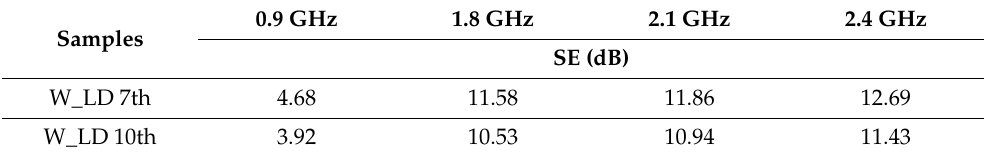
Table 5. Cont. Table 5. Shielding effectiveness (EMSE) of stainless-steel fabric sample (face) before and after the 1st, 3rd, 5th, 7th, and 10th cycles of washing with liquid detergent at frequencies 0.9 GHz, 1.8 GHz, 2.1 GHz, and 2.4 GHz .